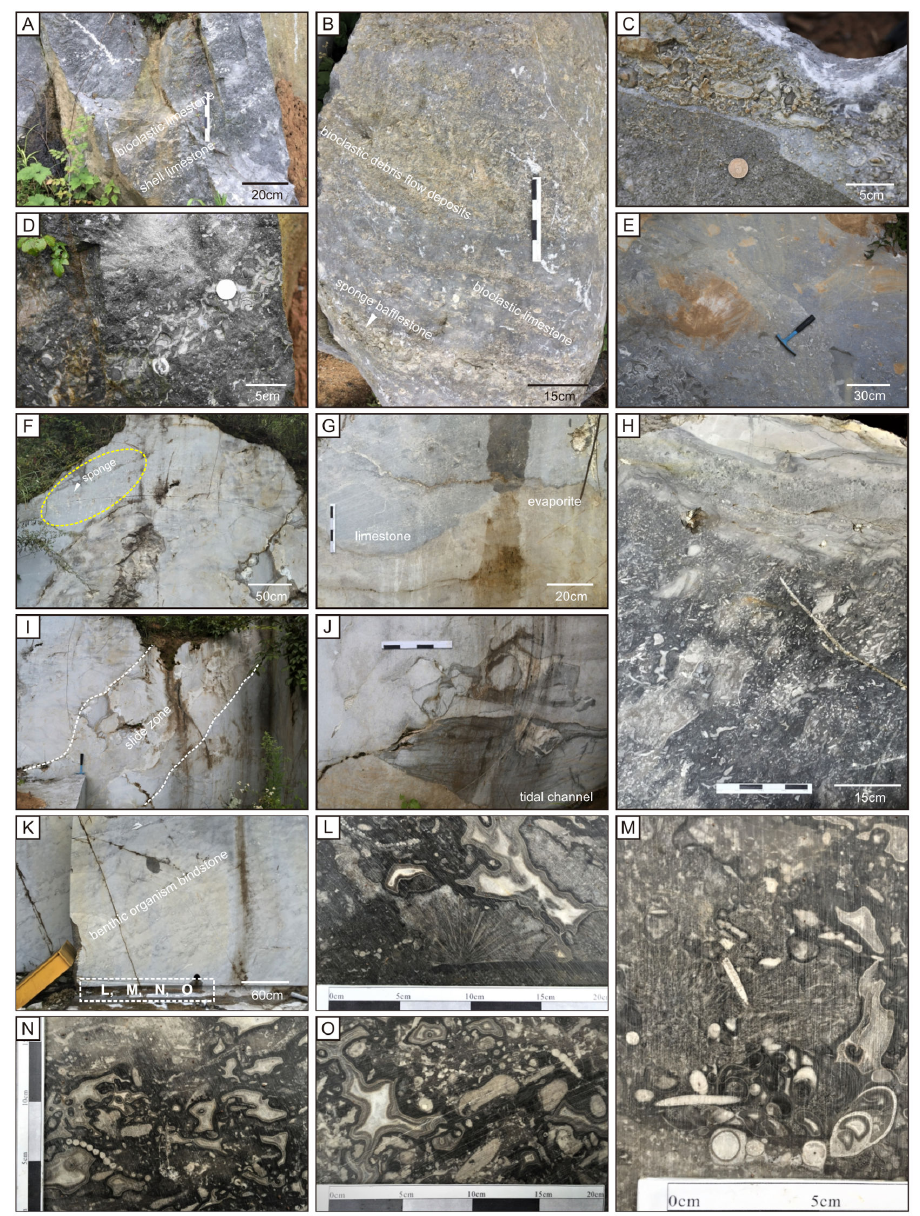
Figure 9. Images of the outcropping lithofacies: ( A ) benthic-organism bindstone; interbedded dark gray bioclastic limestone and light gray bioclastic limestone; ( B ) small bioclastic debris flow deposits at the upper part and a 10–20cm thick sponge bafflestone at lower part; ( C ) bioclastic debris; ( D ) benthic-organism bindstone; dense shell layer with shells occluded by sparry calcite; ( E ) reef front deposits; ( F ) reef flank slide structure; ( G ) limestone covers the evaporite rock (the part of reef cap); ( J ) tidal channel incise the reef cap sediments at the flank of the reef; ( H ) restricted lagoon; located at the back reef area; ( K – O ) benthic-organism bindstone; ( L ) Fan-shaped aragonite